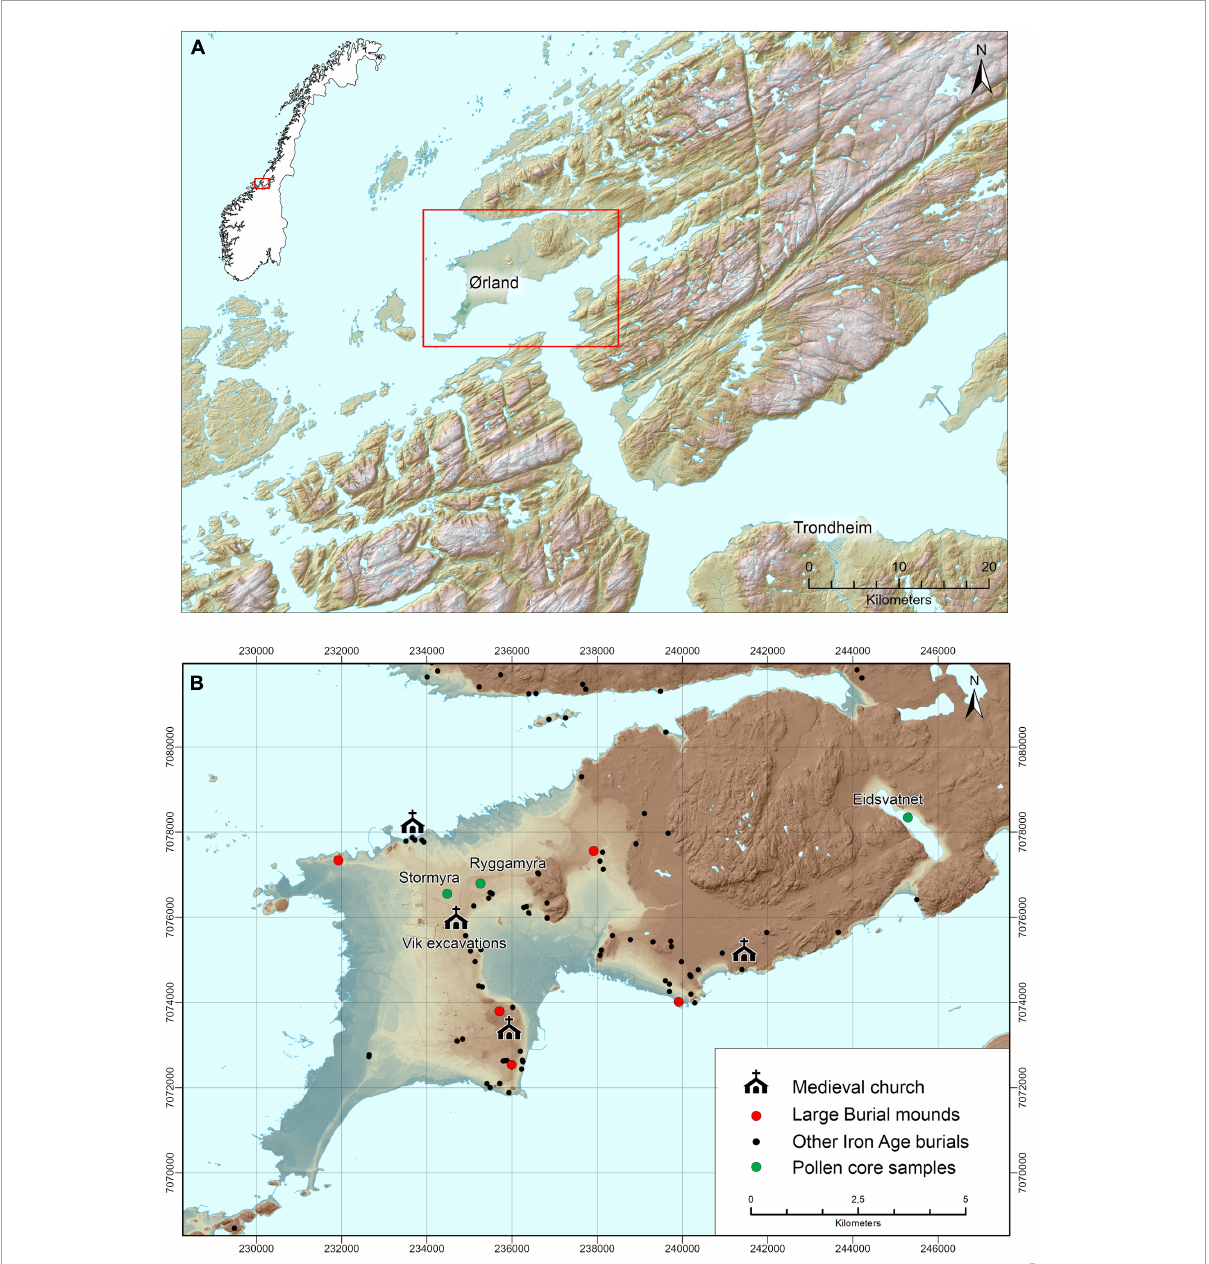
FIGURE1 Map of study area. (A) The peninsula with Ørland and its surroundings, (B) detailed map showing the localities for pollen analysis in relation to large burial mounds, Iron Age graves and medieval churches. Illustration: Magnar Mojaren Gran, NTNU University Museum.